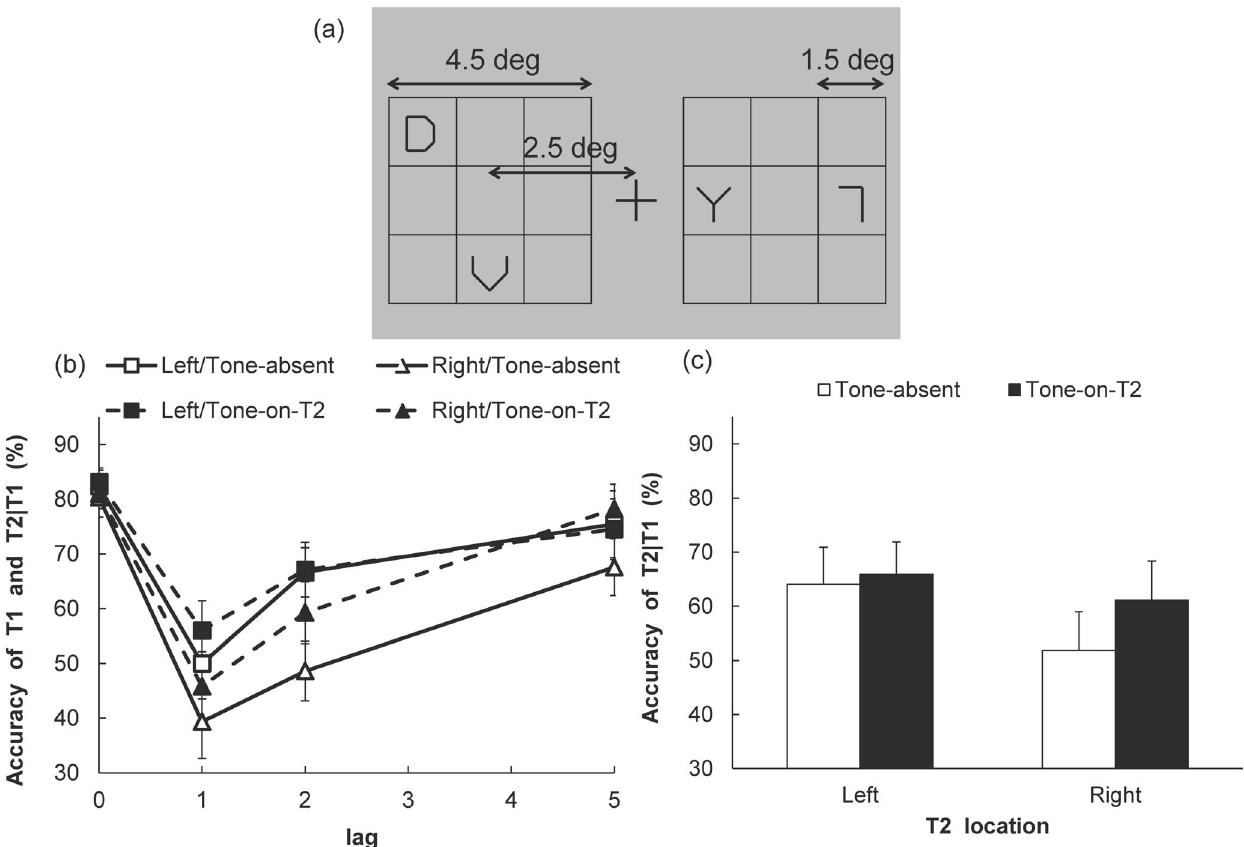
Figure 4. Illustration of T1 display and T1 and T2 identification performance in Experiment 2. (a) T1 display: T1 and three distracters were presented at random locations on a 3 6 3 virtual matrix. Two visual stimuli were displayed on each side (left or right) of the fixation. (b) T1 accuracy and T2 accuracy (given that T1 is correct) in each of the Tone, Visual field, and Lag conditions. (c) T2 accuracy (given that T1 is correct) in each of the Tone and T2 visual field conditions. The vertical axes indicate the T2 accuracy (percent correct). Error bars represent standard errors of the mean ( n =9).